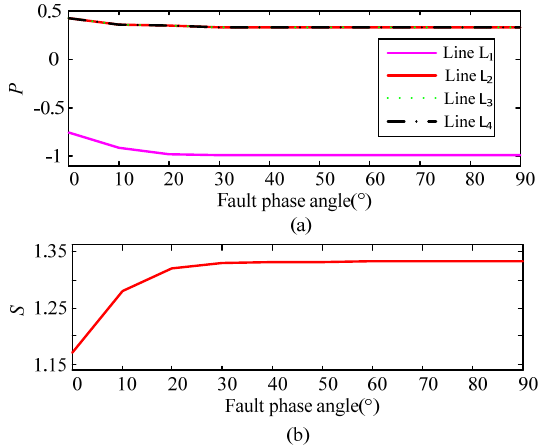
Figure 17. S and P of each feeder for different fault phase angles. ( a ) P of each feeder for different fault phase angles; ( b ) S of different fault phase angles.